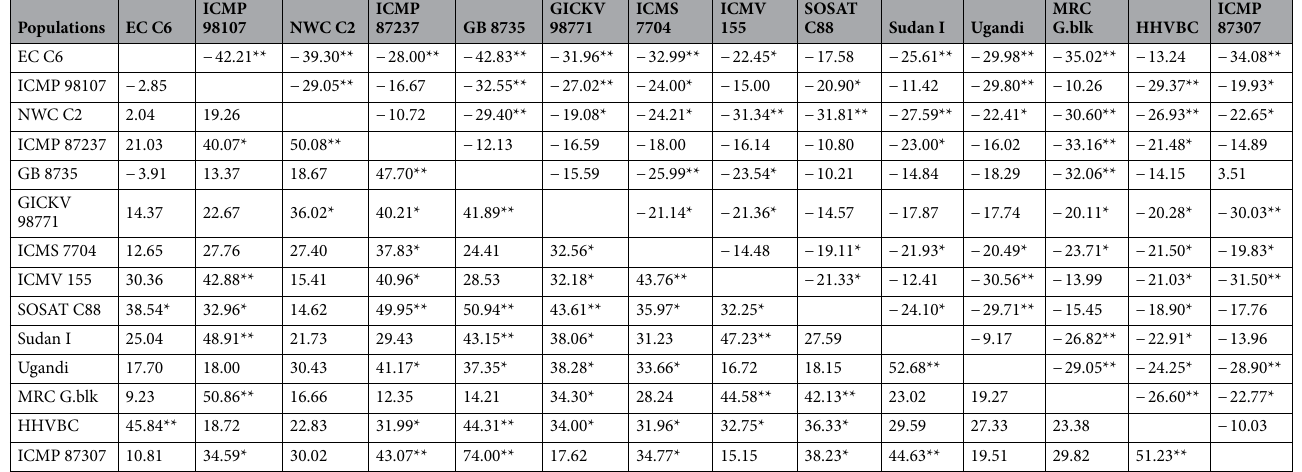
Table 8. Panmictic commercial heterosis (%) over hybrid check ProAgro 9444 (above diagonal) and OPV check ICTP 8203 (below diagonal) of 91 pearl millet population hybrids across three locations. *, ** Significant at 0.05 and 0.01 levels of probability, respectively.